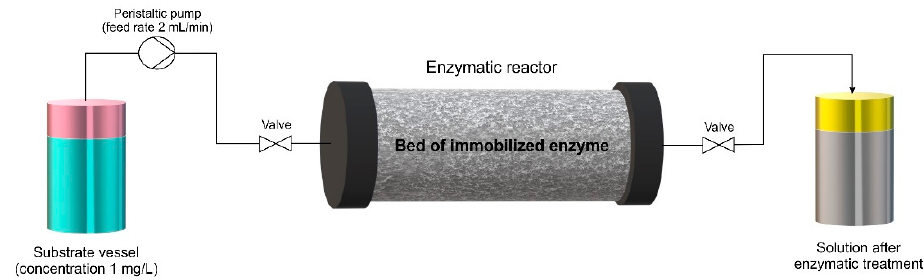
Figure 3. The packed bed reactor system used in the study for continuous removal of tetracycline.